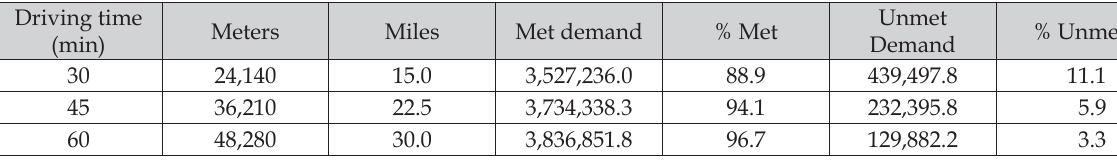
Table 3. Aggregated block model results